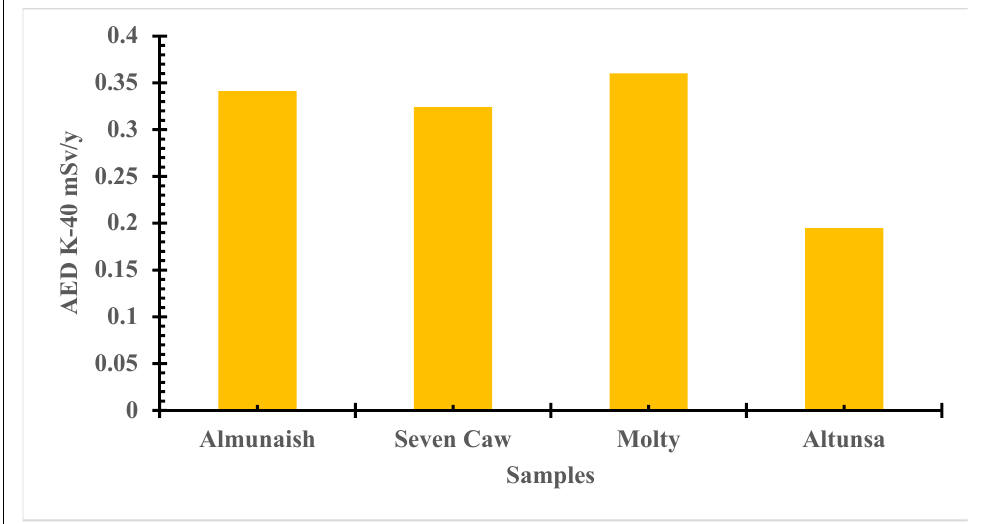
Fig. 6: AED (mSv/y) for 40 K in all